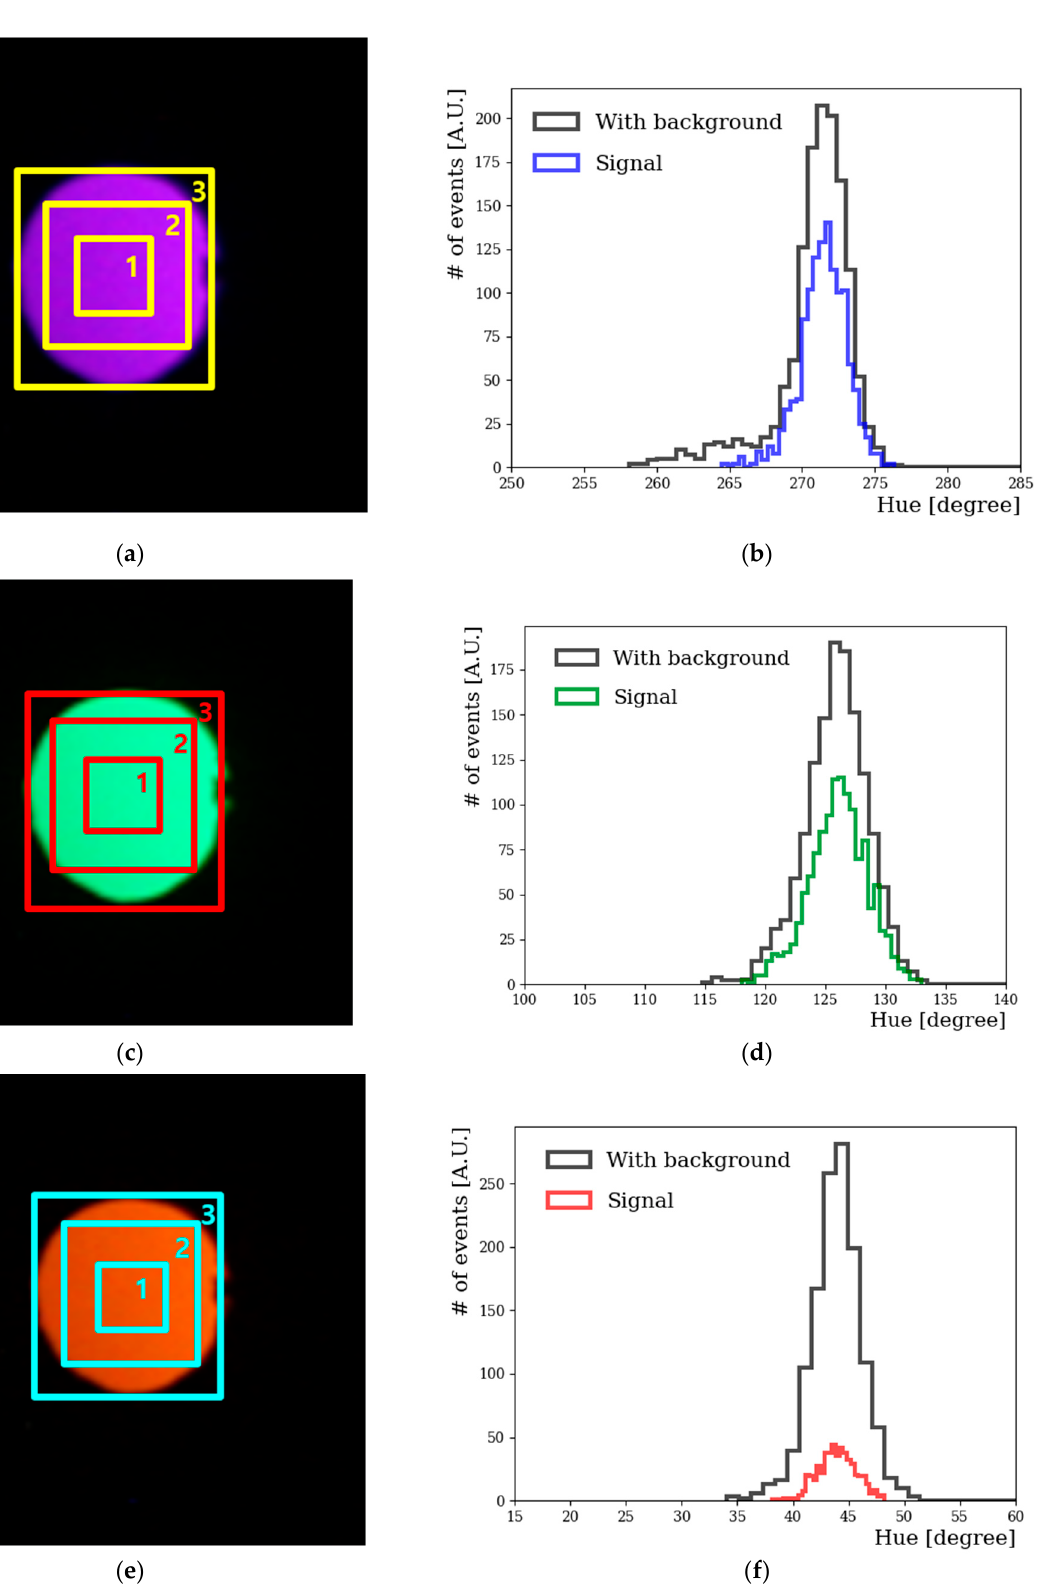
Figure 5. Color image ( a , c , e ) and hue distribution ( b , d , f ) with Canon EOS 450D using CFA technology at wavelengths of 380, 590, and 630 nm, respectively. The rectangular box represents the value of V, and the first box corresponds to approximately 0.6. Hue distributions are shown in ( b , d , f ) before and after the V cut was applied.